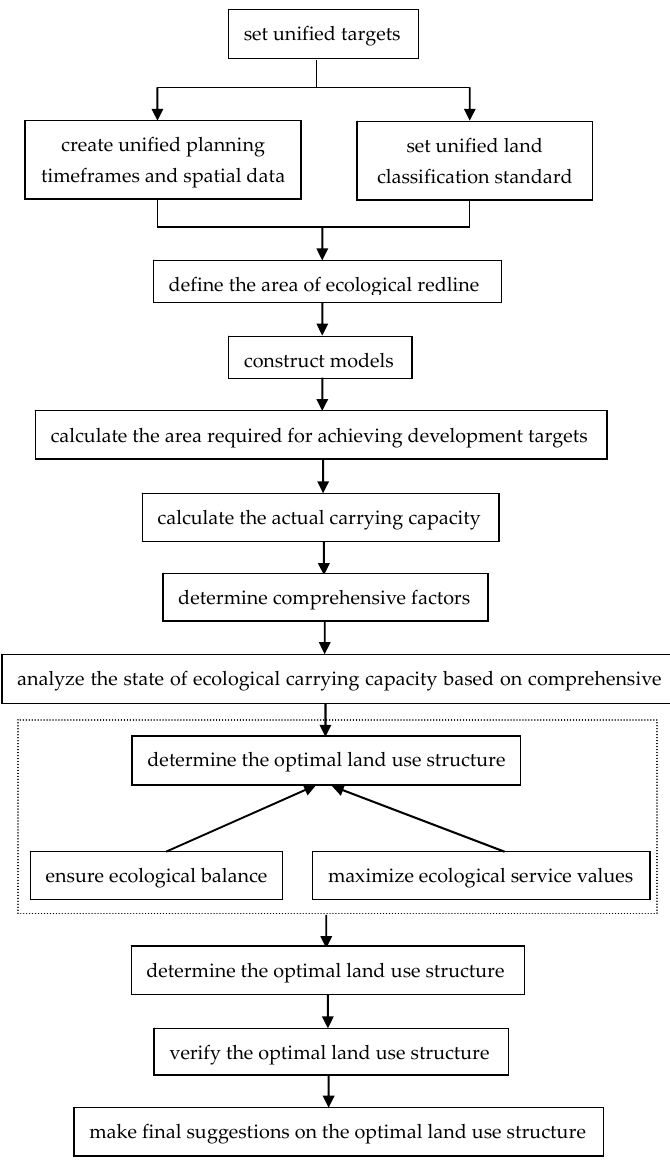
Figure 1. Flowchart of research